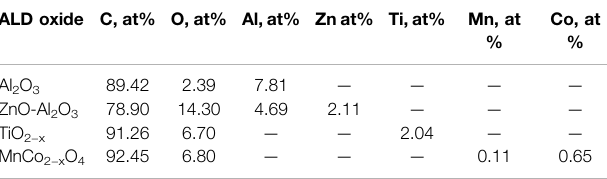
TABLE 3 | Elemental compositions in various AC electrode